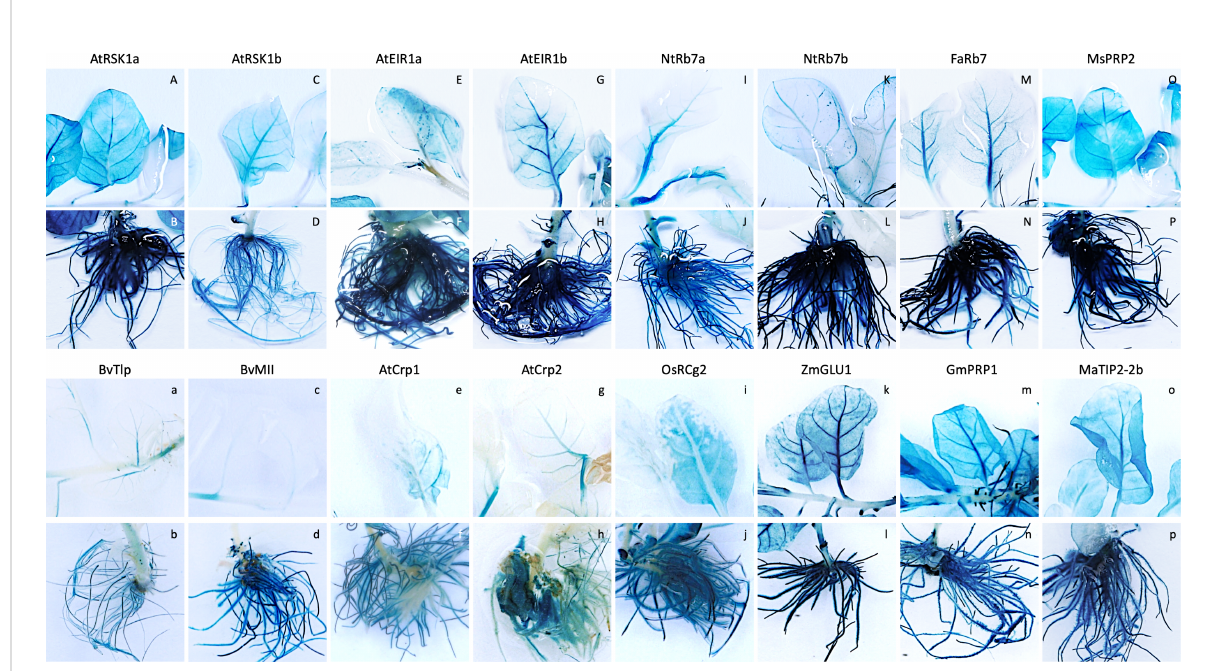
FIGURE 1 Expression pattern of promoter- uidA constructs in leaf and root tissues of selected transgenic tobacco lines. Transgenic promoter- uidA tobacco plants were generated and whole plants were stained to visualize GUS expression. Promoter constructs shown include (A, B) Arabidopsis thaliana root-speci fi c kinase homolog 1a (AtRSK1a), (C, D) AtRSK1b, (E, F) A thaliana ethylene insensitive root 1a (AtEIR1a), (G, H) AtEIR1b, (I, J) Nicotiana tobacum Rb7a NtRb7a, (K, L) NtRb7b, (M, N) Fragaria ananassa Rb7 (FaRb7), (O, P) Medicago sativa proline rich protein 2 (MsPRP2), (A, B) Beta vulgaris thaumatin-like protein (BvTlp), (C, D) B vulgaris major latex-like protein (BvMll), (E, F) A thaliana cryptic root-speci fi c promoter 1 (AtCrp1), (G, H) AtCrp2, (I, J) Oryza sativa root-speci fi c cDNA 2 (OsRCg2), (K, L) Zea mays b -glucosidase 1 (ZmGLU1), (M, N) Glycine max proline-rich protein 1 (GmPRP1) and (O, P) Musa acuminata tonoplast intrinsic protein 2-2b